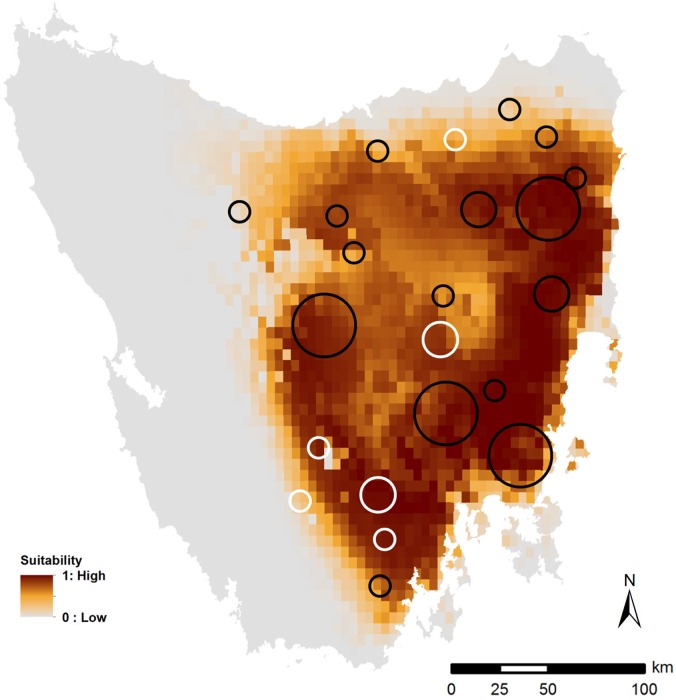
Map of Tasmania showing spatial distribution of changes in mean index of eastern quoll abundance (AI) by region over the 10 years to 2009, as recorded in annual spotlight surveys, overlaid onto the predicted core habitat distribution for the eastern quoll as defined by the binary weather model.Change in AI is calculated as the change in the mean annual number of quoll sightings from 1997–99 to 2007–09 for each spotlighting region, based on the 150 transects consistently surveyed in each of these two periods [7]. White circles indicate an increase in AI, black circles indicate a decrease in AI for each region. Circle size indicates relative magnitude of absolute increase or decrease in AI, being large circles (>6 quoll sightings), medium circles (3–6 sightings), and small circles (<3 sightings). Eight regions have been excluded from this analysis, as there were either no eastern quoll detections in the region during the 10 year period (7 regions), or there was no change in the AI over the 10 year period (1 region).